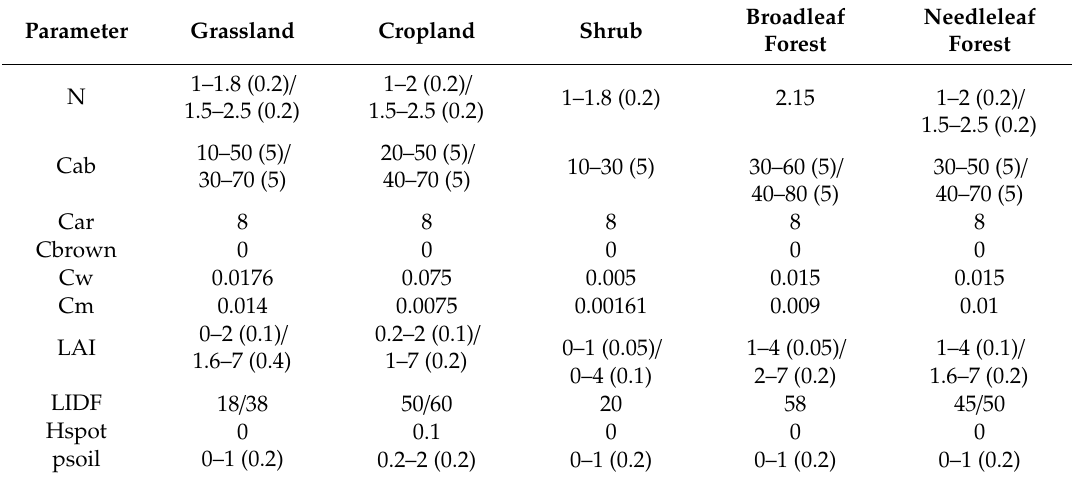
Table 6. Inputs to the PROSAIL model for di ff erent vegetation